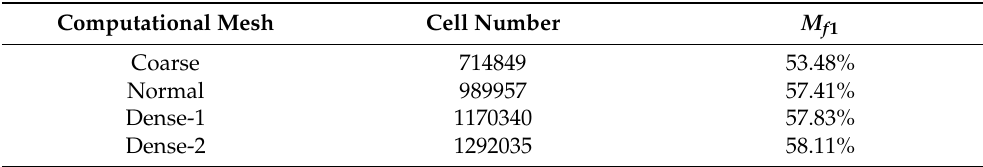
Table 2. Cross-sectional uniformity indices ( M f 1 ) for Section 1 obtained from numerical calculations for different cell